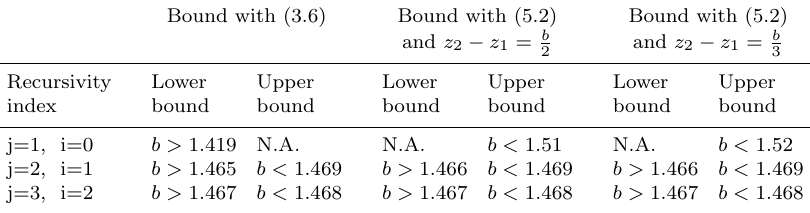
Table 1. Comparison of bounds for b in the Example 1. Bound with (3.6) Bound with (5.2) Bound with (5.2) and z 2 z 1 = b and z 2 z 1 = b 2 3 − − Recursivity Lower Upper Lower Upper Lower Upper index bound bound bound bound bound bound j=1,